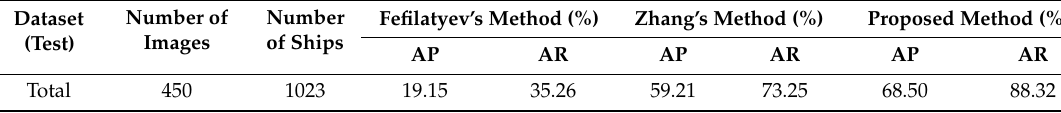
Table 9. Precision and recall scores of the three ship detection